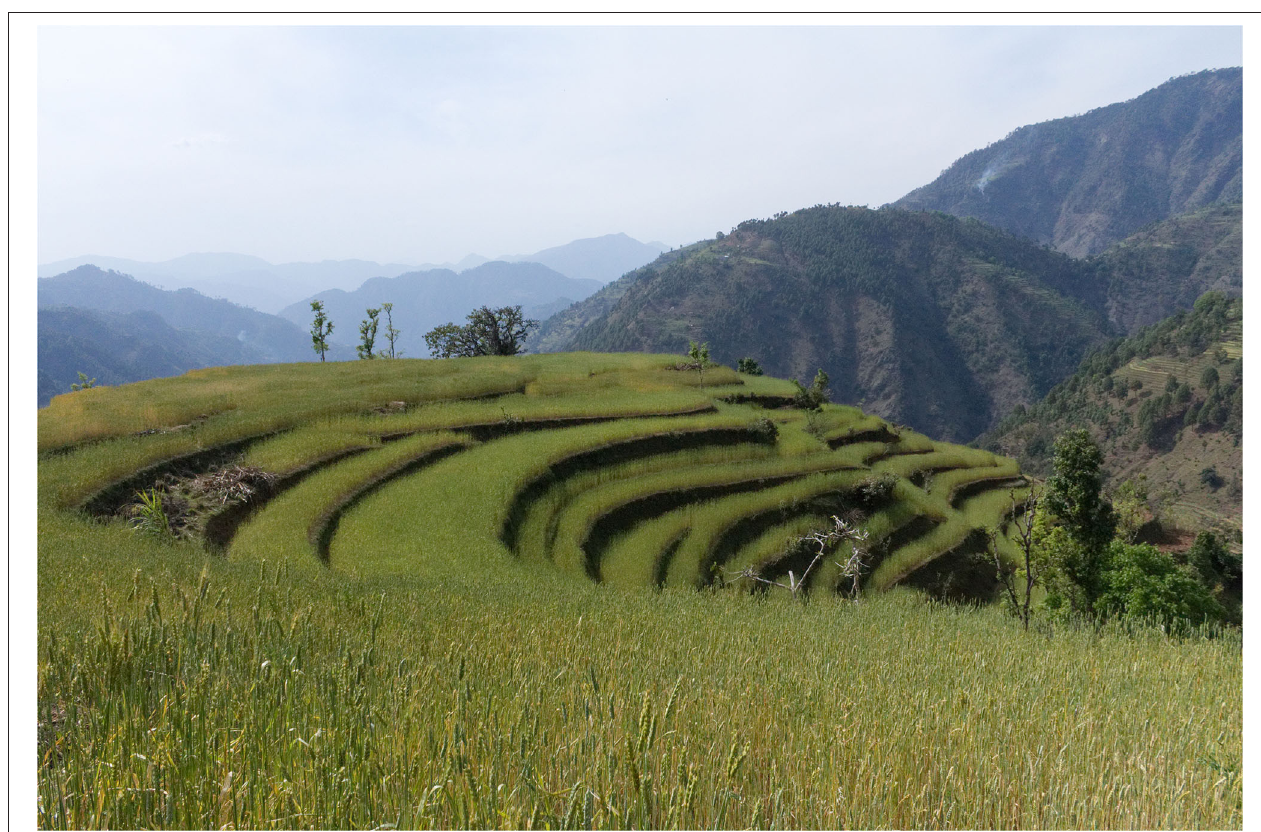
FIGURE 1 | Wheat and barley growing on terraces in